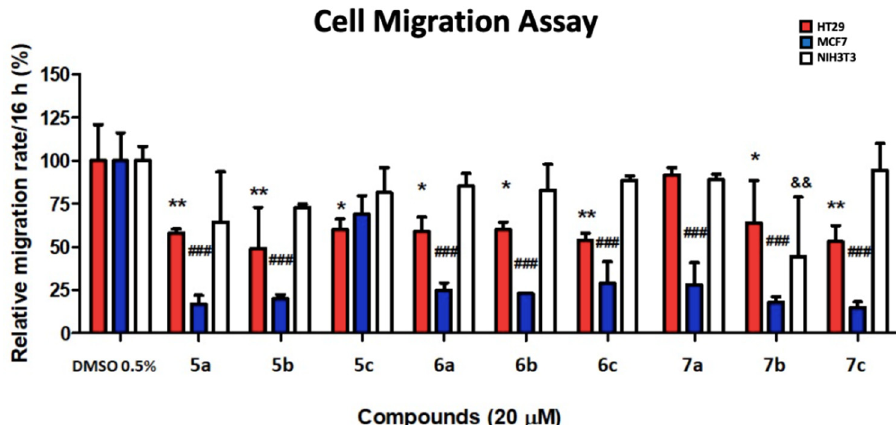
Figure 5. Effect of curcumin-derived compounds on the migration capacity of two tumor cell lines: HT29 and MCF7, and the non-tumoral NIH3T3 cell line. Cells were seeded in 24-well plates and a wound-healing assay was conducted in the presence of the distinct compounds (20 µ M of final concentration). Microphotographs were taken at 0 and 24 h to calculate the percentage of cell-free area reduction, which is directly dependent on the in vitro cell migration. Results are expressed as the mean + SD of the relative migration rate in 16 h regarding the control (DMSO 0.5% as 100% of cell migration) and are representative of three independent experiments. The statistical significance shown is with respect to the controls (DMSO 0.5%), * p < 0.05; ** p < 0.01, for HT29; ### p < 0.001 for MCF7, and && p < 0.01 for NIH3T3 cells.